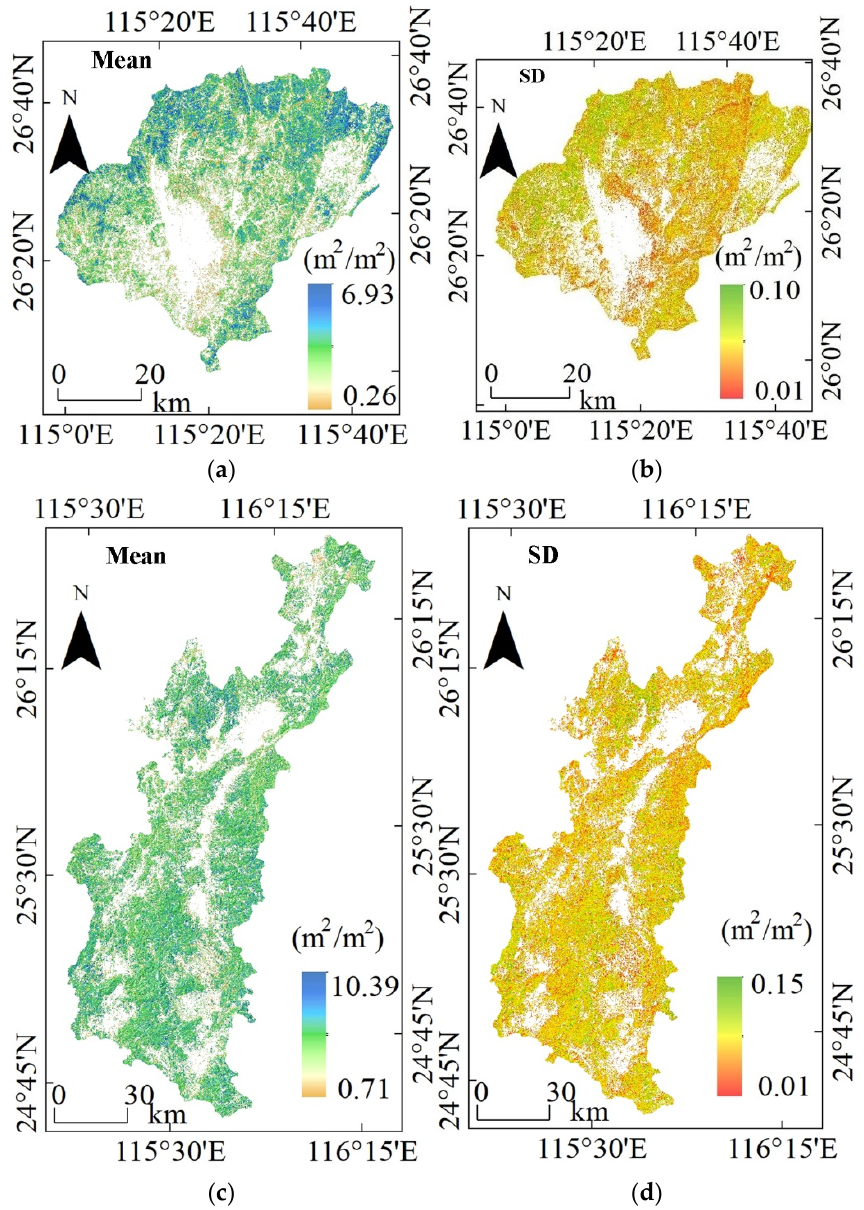
Figure 8. Mean and standard deviation (SD) of LAI predicted from 100 runs of the SL model for ( a , c ) Xingguo and ( b , d ) Gandong.